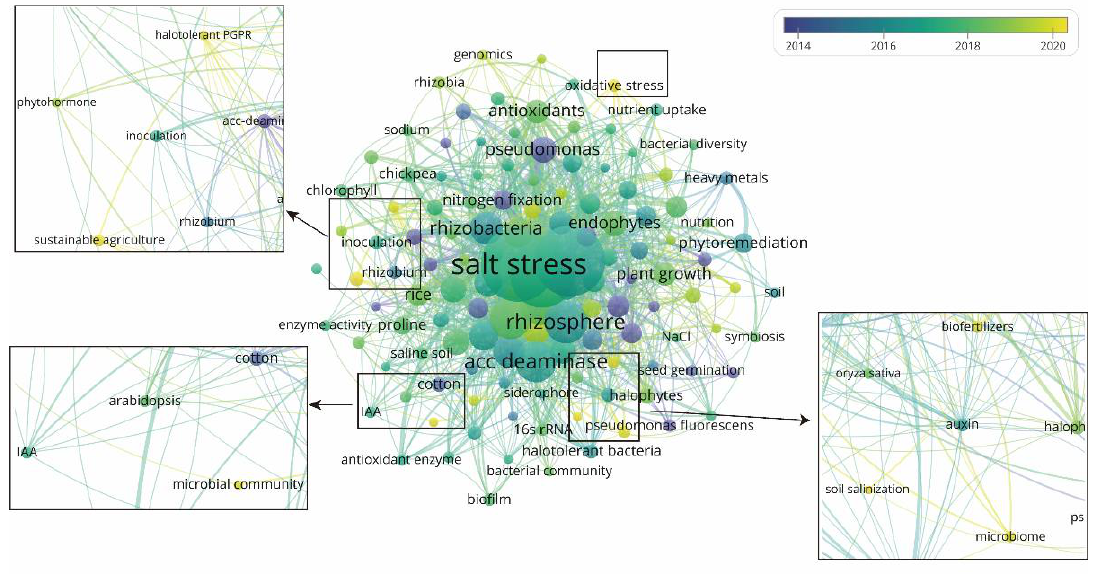
Figure 7. Overlay visualization map of keyword co-occurrence analysis generated by VOSviewer software.